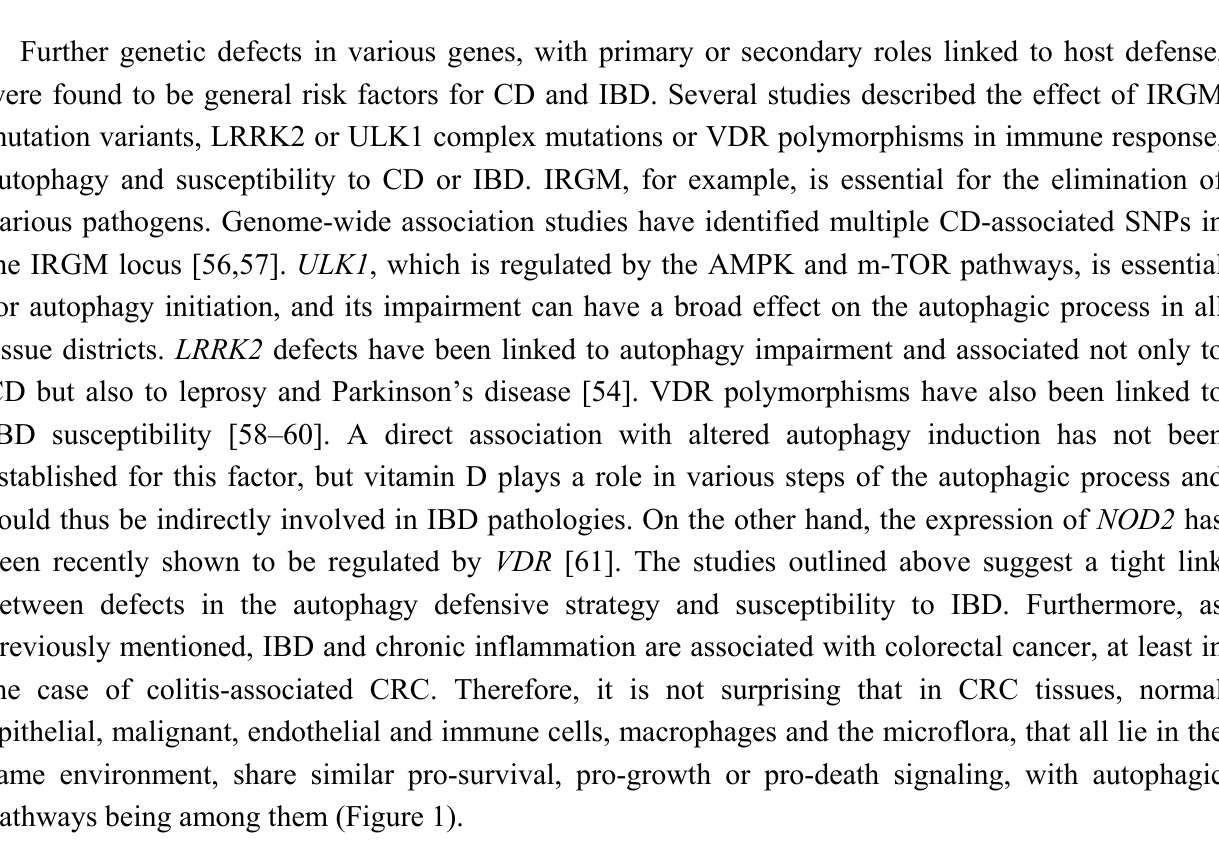
Figure 1. p38  inhibition: A new approach to fight inflammation and colorectal